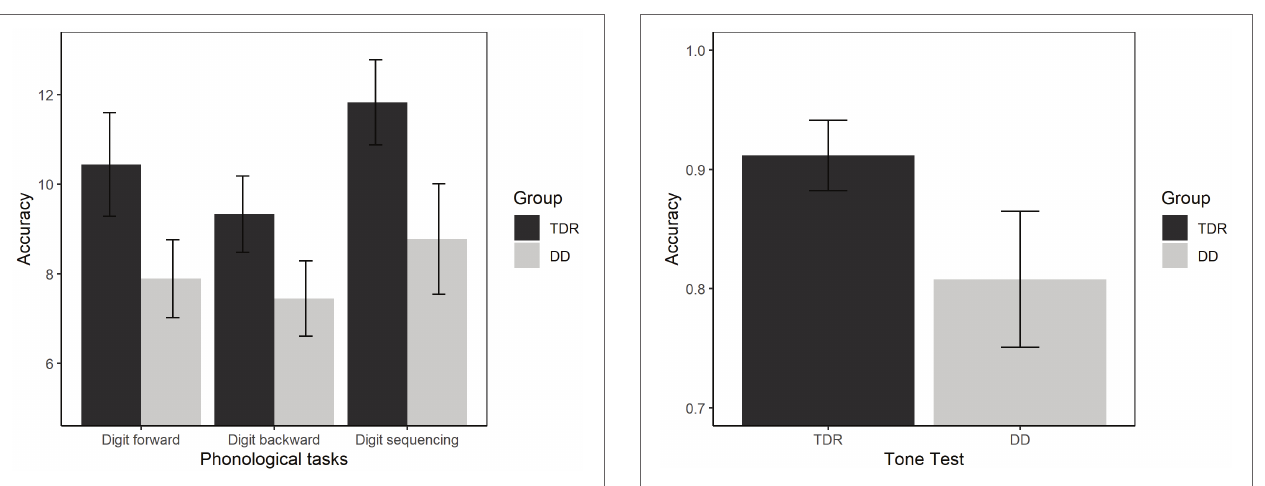
FIGURE 8 | Accuracy in phonological tasks. Error bars represent standard errors. TDR, typically developing readers, DD, developmental dyslexics.